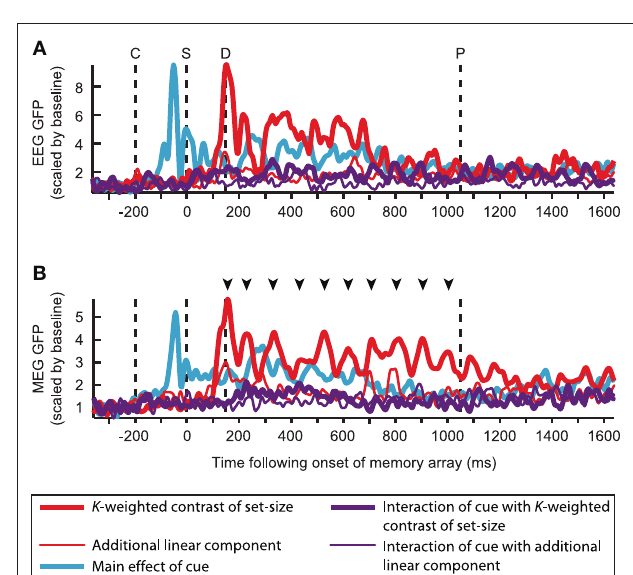
Figure 5 | global field power (gFP) of the grand mean of each contrast of interest, for eeg (A) and Meg (B) . Each contrast is scaled by the mean of its baseline activity. Time-points C, S, D, and P respectively mark the onsets of the cue, sample, and the earliest onset of the probe array; arrowheads mark the peaks of the K -weighted response for which source estimates are shown in Figure 7